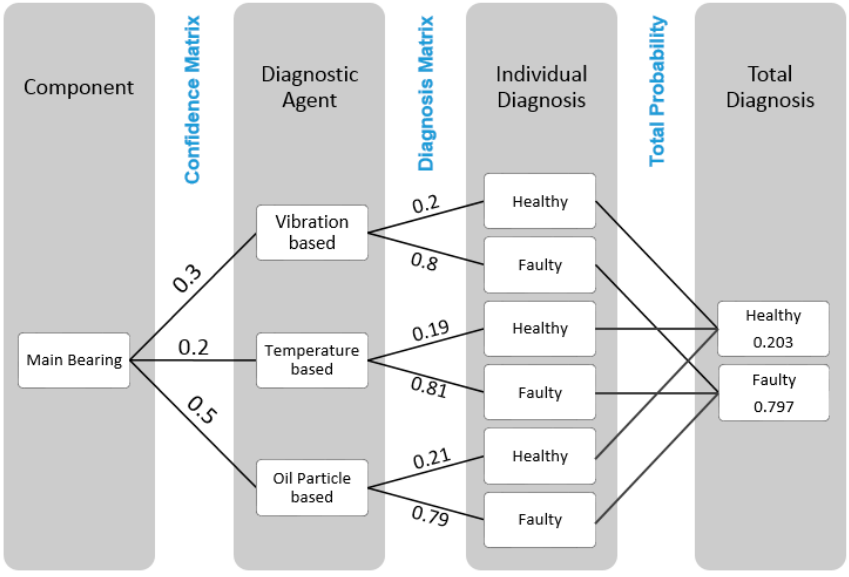
Figure 10. Overview of the case study results of a wind turbine’s main bearing.